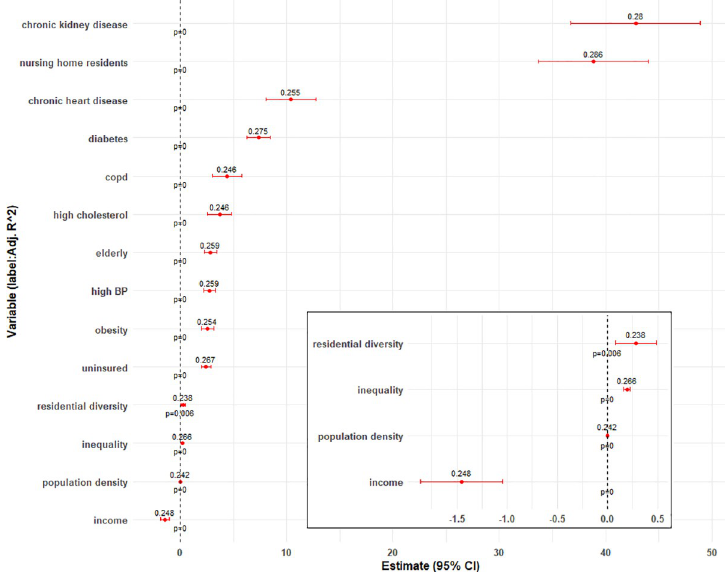
Fig 5. Estimates (95% CI) of health and socioeconomic indicators in a linear univariate model with death rate as outcome and adjusting for COVID-19 case rates. Labels indicate adjusted R 2 . Inset magnifies select variables of smaller estimates. COVID, Coronavirus Disease